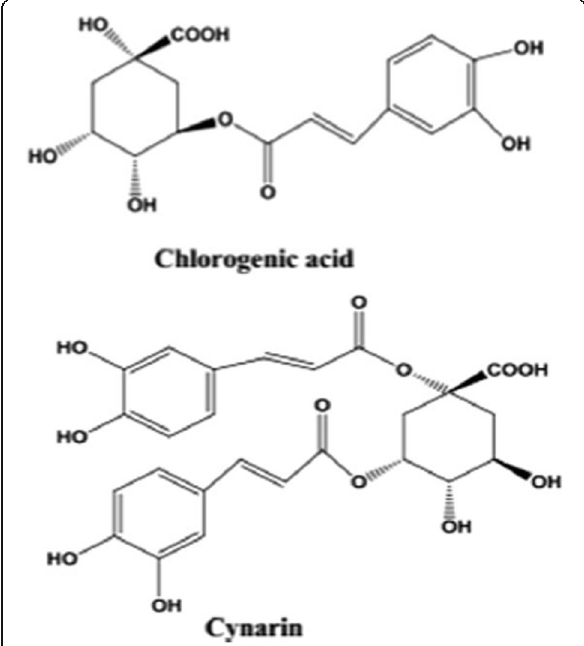
Fig. 10 Chemical structure of chlorogenic acid and cynarin by Ben Salem et al.